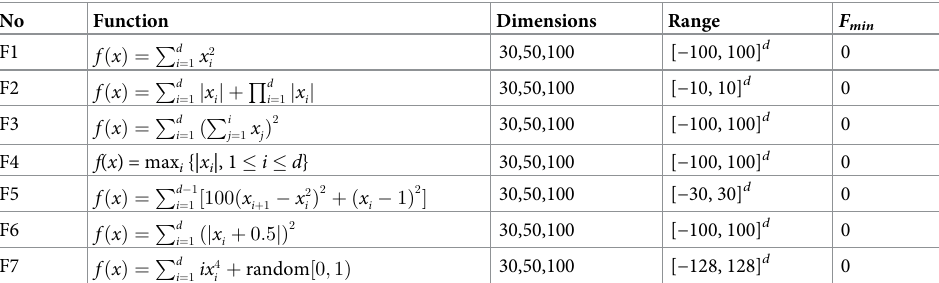
Table 1. Details of unimodal test